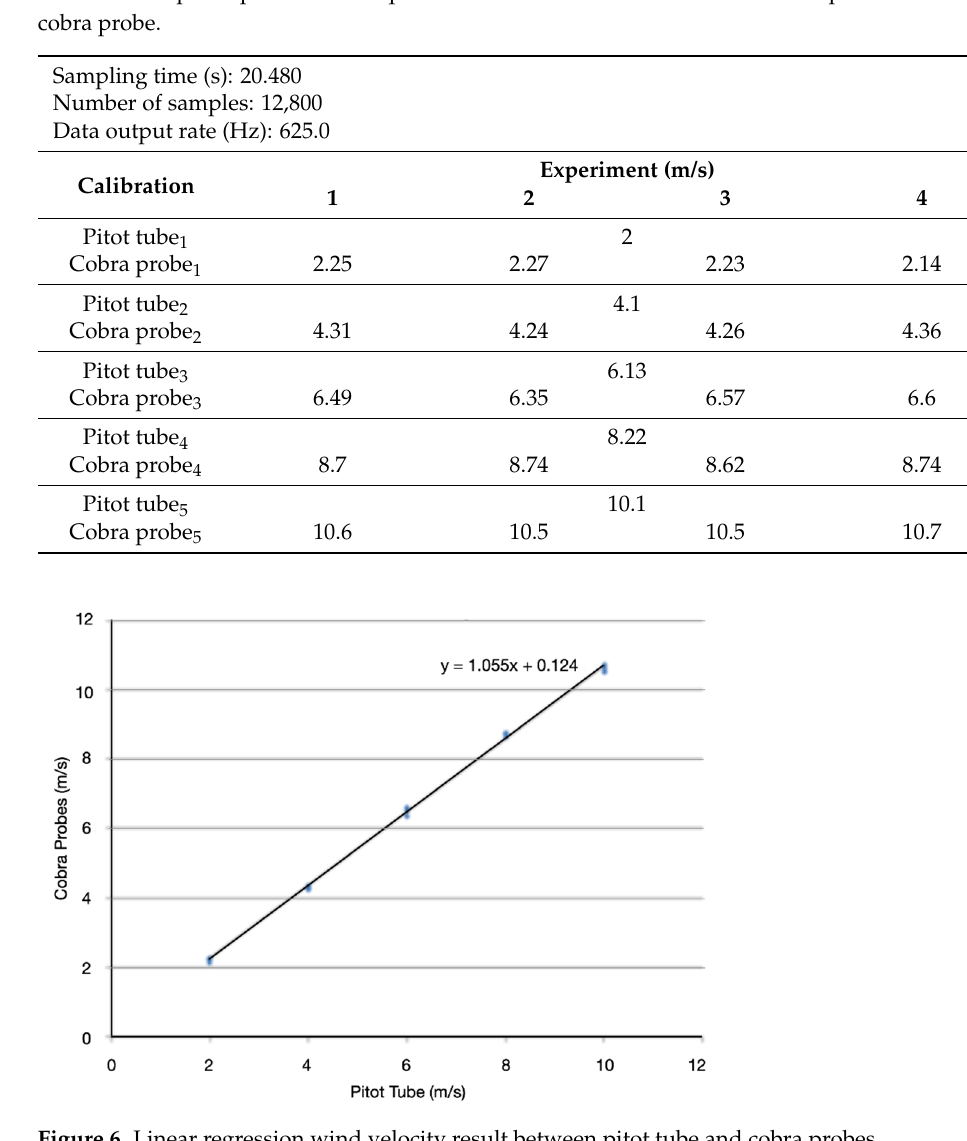
Figure 6. Linear regression wind velocity result between pitot tube and cobra probes. Table 1. Simple experiment to equate the wind tunnel result between the pitot tube and the cobra probe.